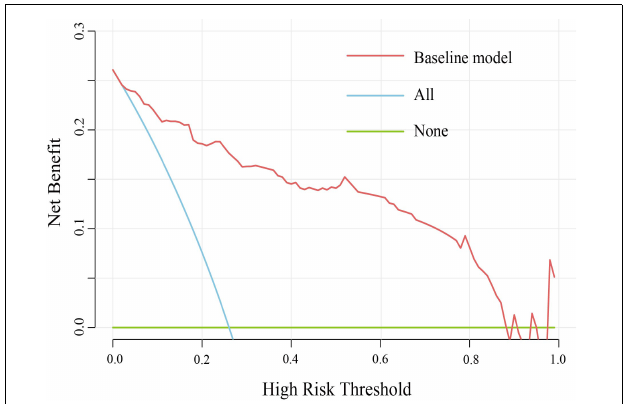
lymph node metastasis in early-stage CC and confirmed it had good diagnostic ability (18–20). However, this study focused on only quantitative parameters of PET/CT (SUVmax), ignoring the effect of tumor size and the uterine corpus invasion.